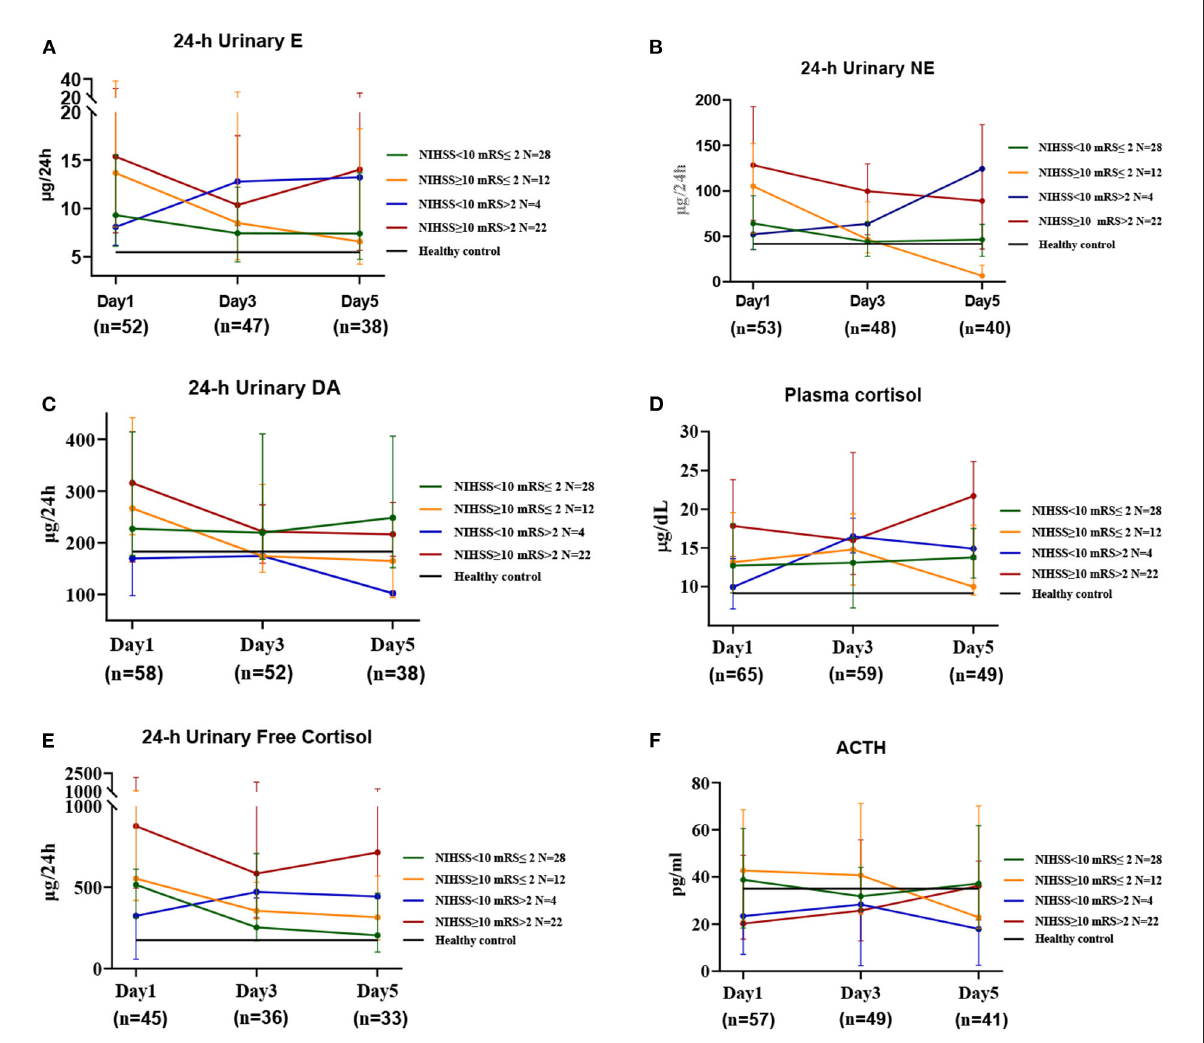
FIGURE2 The changes in HPA axis hormones and catecholamines in stroke patients at three time periods. This includes the first day (Day 1), the third day (Day 3), and the fifth day after admission (Day 5). Median values for the 3 time periods show good and poor prognoses for patients with mild and severe disease at admission, respectively. Healthy controls show relative mean values, n = 237, age = 61.0 ( ± 9.5) years; N ’ refers to the number of cases in different prognosis and severity groups; n ’ refers to the number of specimens in different time periods.